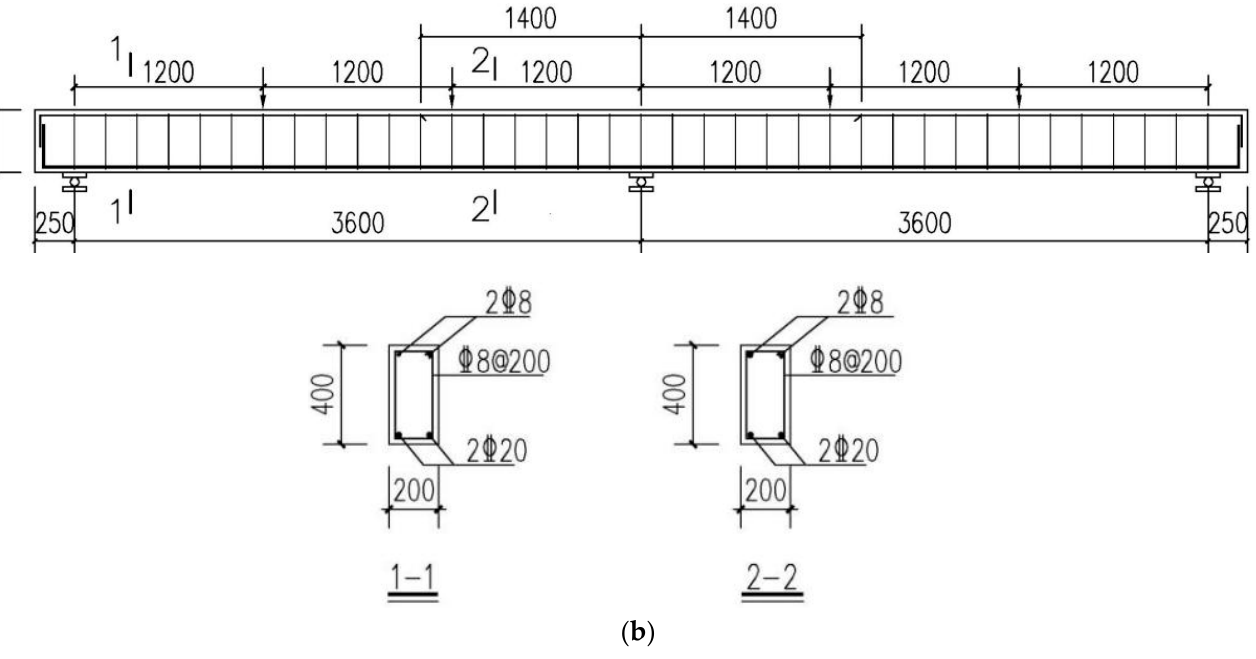
Figure 1. Arrangements of rebars for beams: ( a ) Simply supported beam; ( b ) Continuous beam. Table 2. Mix proportion of concrete.